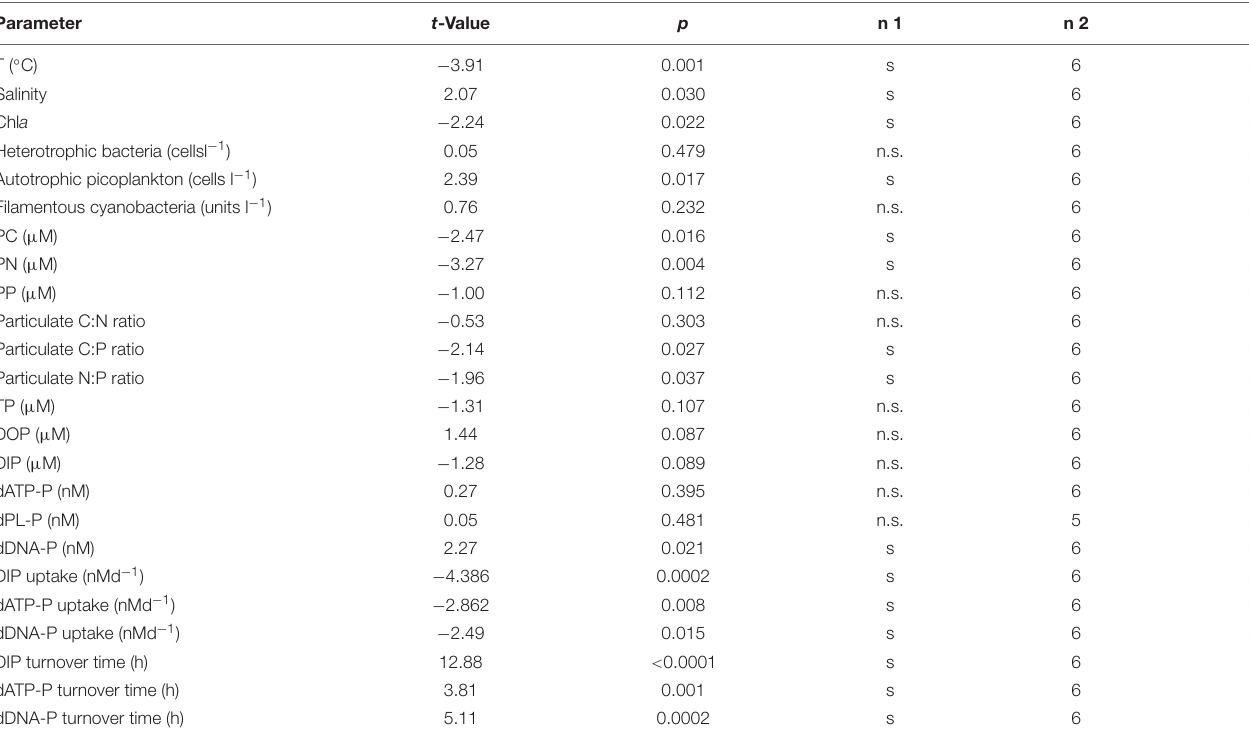
TABLE 3 | Results of the t -test to validate if the differences between the southern and the northern stations of the transect investigated in summer 2011 were significant at a level p < 0.05.